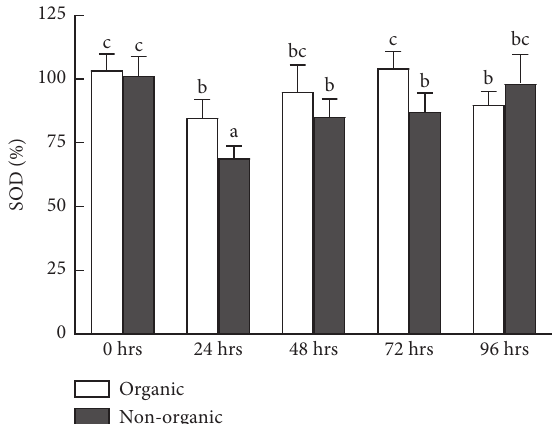
Figure 3: SOD activity organic and nonorganic vegetable soups at 0 h, 24h, 48h, 72 h, and 96 h. Each data point is the mean of triplicated data with ± SE. The bars represented with different letters are significantly different from each other at p � 0 . 05 as evaluated by